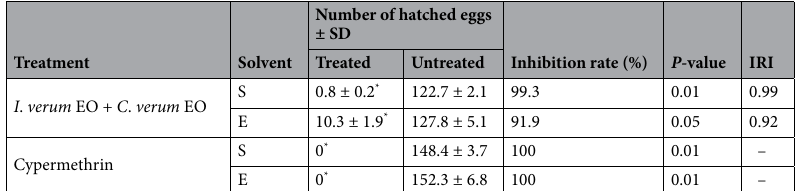
Table 5. Inhibition rate against Periplaneta americana eggs at 30 days after treated with a combined formulation of 5% I . verum EO + 5% C . verum EO and 10% cypermethrin, both in soybean oil and in ethyl alcohol solvents. IRI Inhibition Rate Index, S Soybean oil solution, E Ethyl alcohol solution, * Treatment and non-treatment are significantly different at P < 0.05.